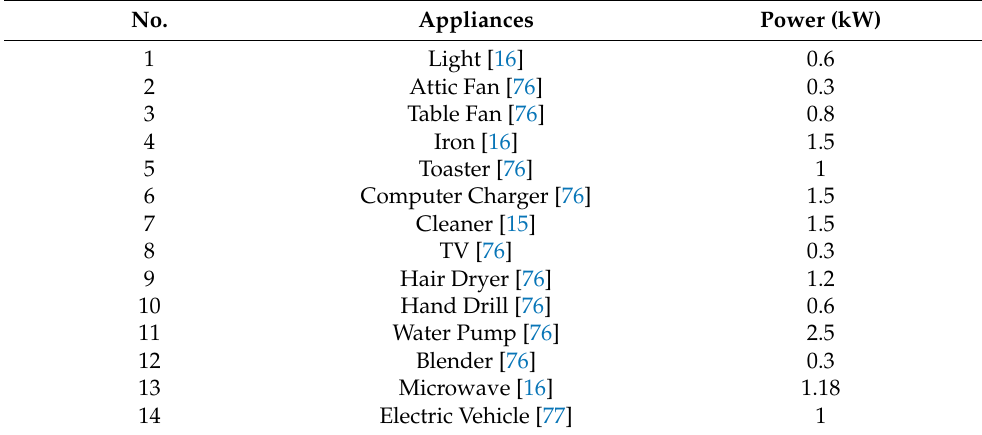
Table 3. Non-shiftable appliances (NSAs) used in the simulation.